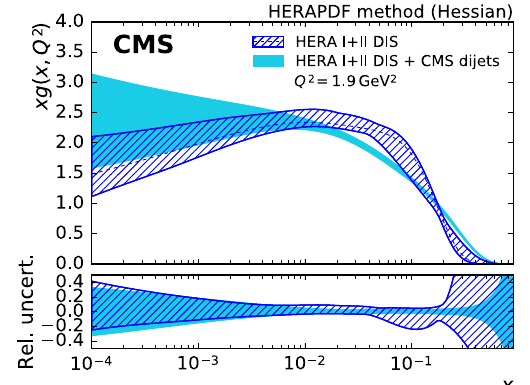
Fig. 10 The gluon PDF as a function of x as derived from HERA inclusive DIS data alone (hatched band) and in combination with CMS dijet data (solid band). The PDF and its total uncertainty are shown at the starting scale Q 2 = 1 . 9GeV 2 of the PDF evolution